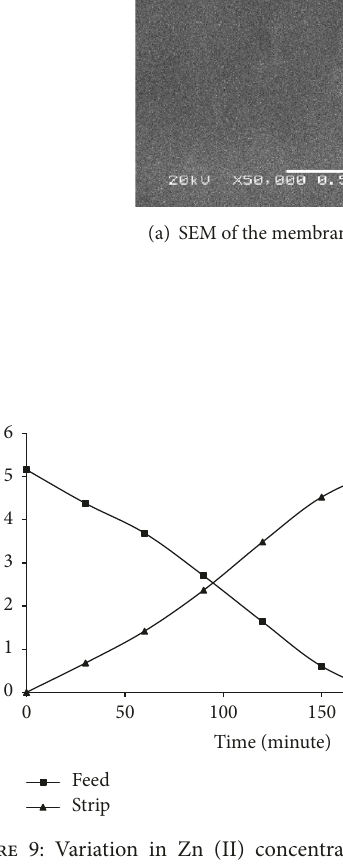
Figure 9: Variation in Zn (II) concentration in feed and strip solution against time (waste discharge liquor of galvanizing plant). Initial Zn (II) conc. in feed = 5.16 × 10 −4 mol/dm 3 , [HCl] in feed = 2.0 mol/dm 3 , [NaOH] in stripping solution = 2.0 mol/dm 3 , [TDDA] in membrane phase = 0.80 mol/dm 3